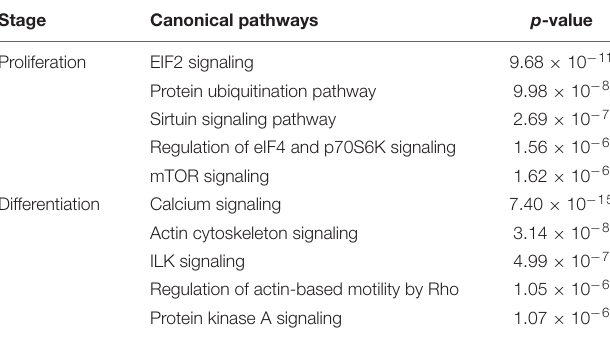
TABLE 2 | Top five canonical pathways affected by DAP knockdown in proliferating and differentiating satellite